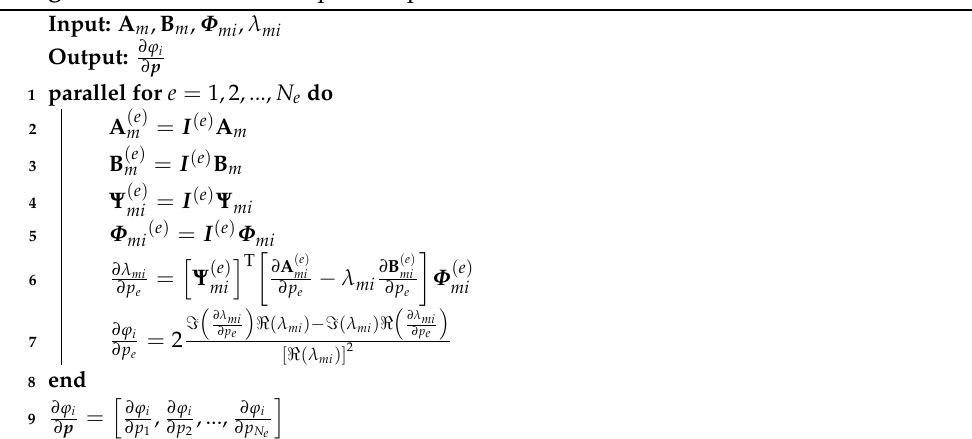
Algorithm 3: Master-slave parallel